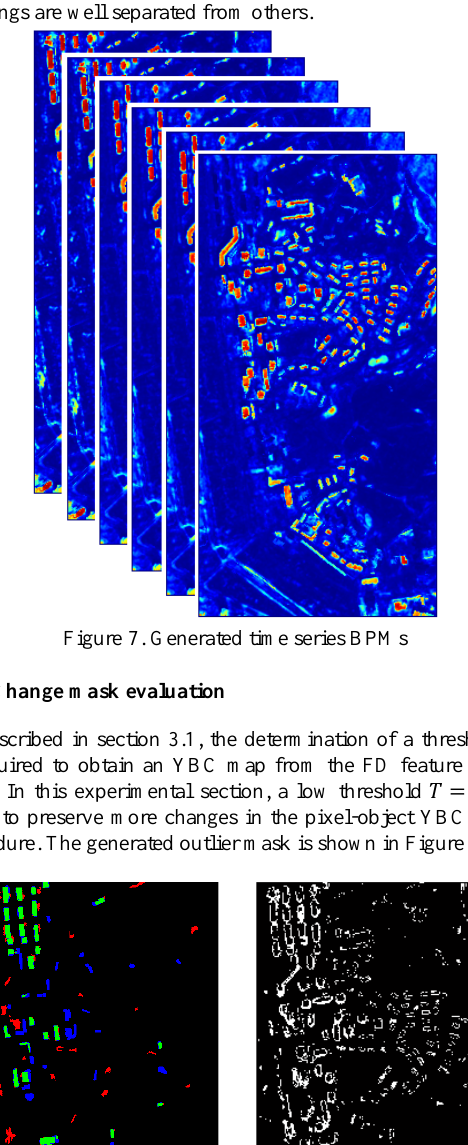
Figure 6. Workflow of the object-based change class map generation.